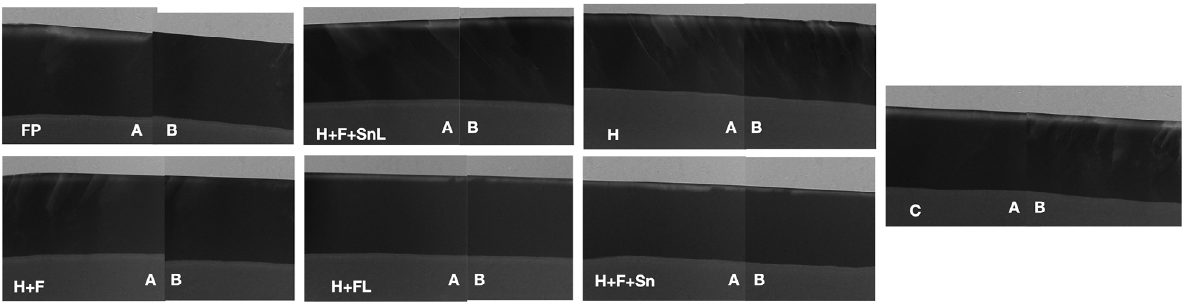
Figure 5- Representative TMR images of each treatment. A: surface adjacent to treatment; B: surface under treatment